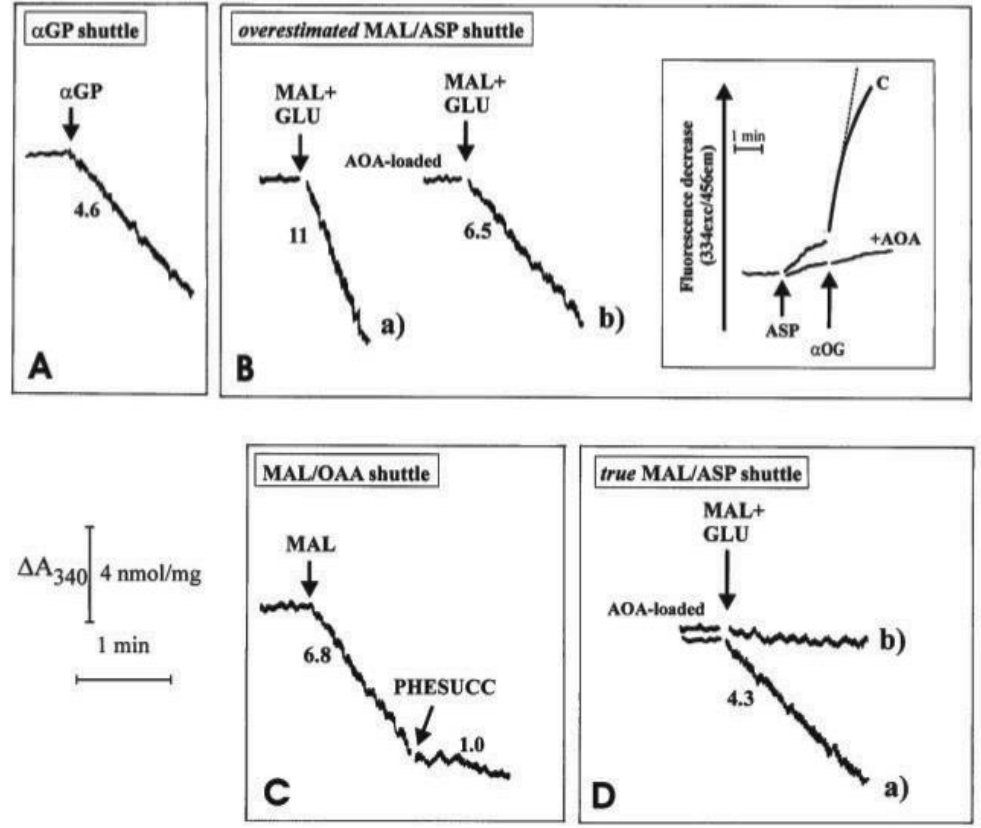
Figure 5. Oxidation of extramitochondrial NADH by WKY5-RHLVM. Reconstruction of the aGP shuttle ( A ), of the overstimated malate/aspartate (MAL/ASP) shuttle ( B ), of the malate/oxaloacetate (MAL/OAA) ( C ), of the true MAL/ASP shuttle ( D ). From [12,32] , with permission from Arcane Editrice, Rome and Spandidos Publications, 2021.